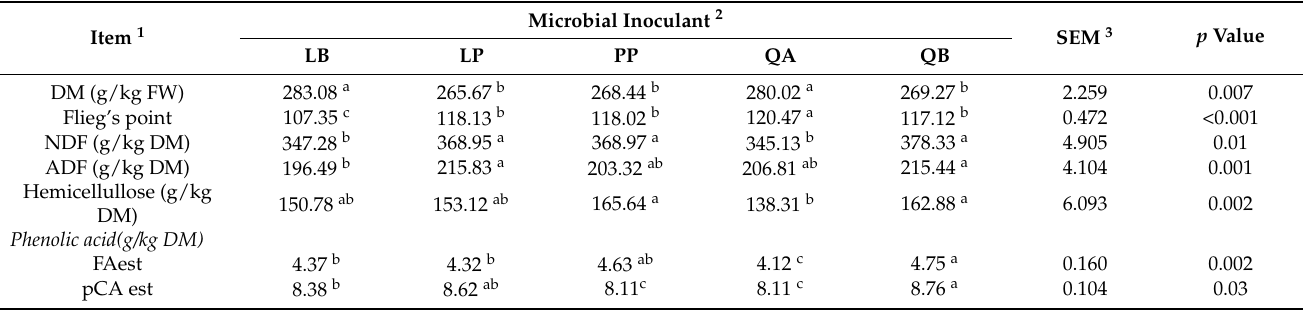
Table 3. Structural carbohydrate compositions of whole corn silages treated with LAB and organic acids after 60 days ensiling.